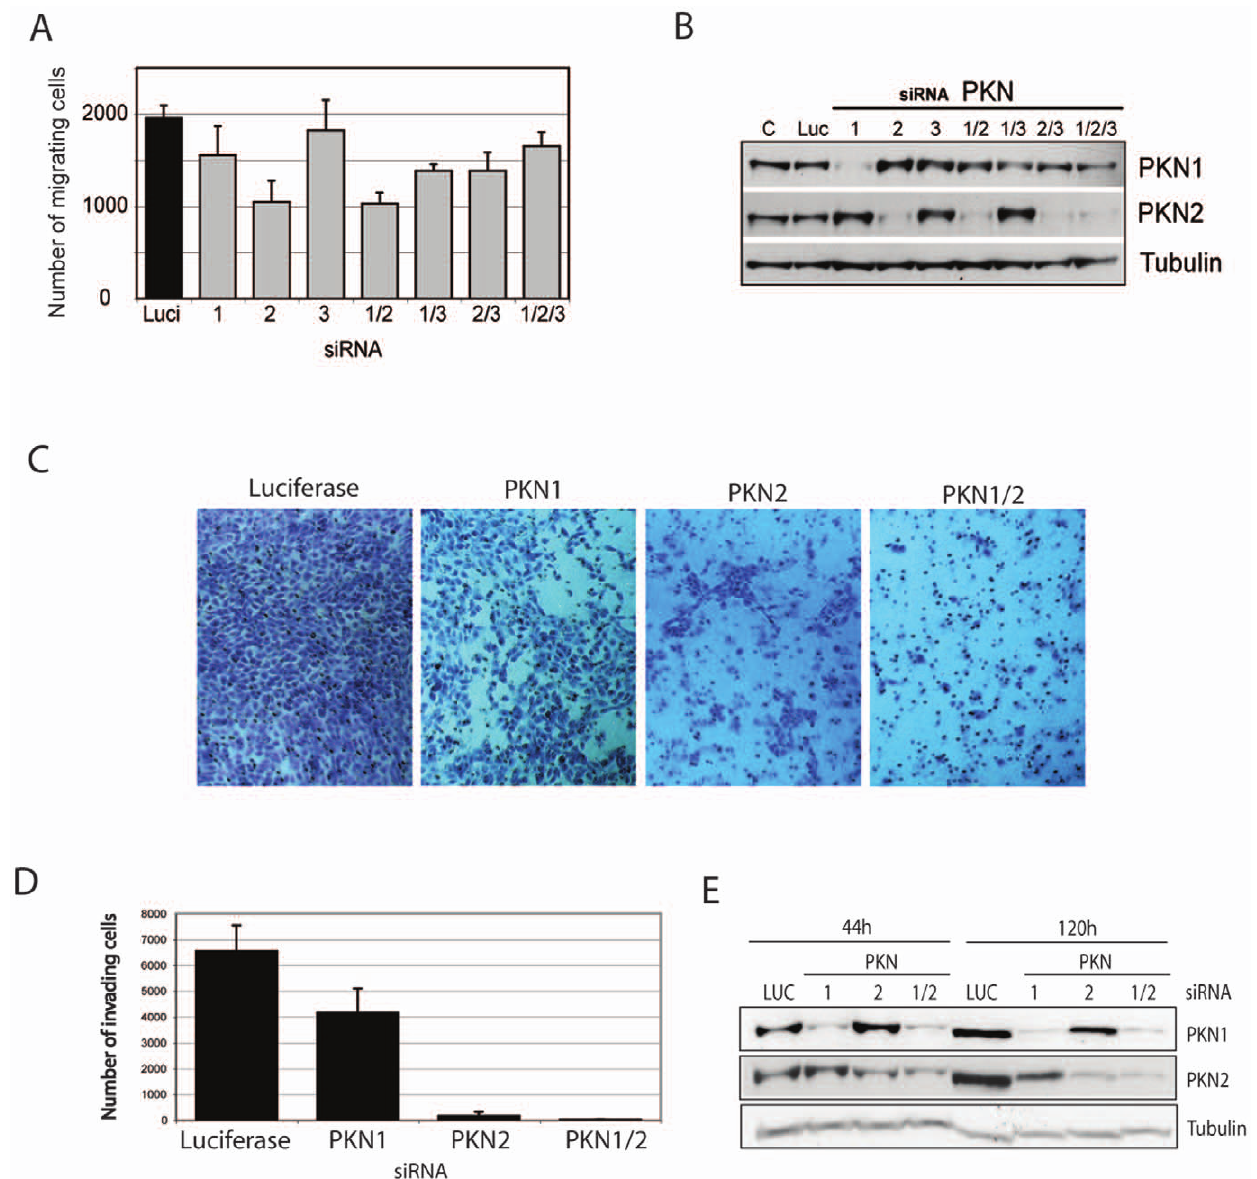
Figure 3. Effect of PKN knock down on tumour cell invasion. A. 5637 cells were transfected with siRNA against all PKN isforms either individually or as a double or triple knock down. 48 h post transfection cells were counted and seeded onto laminin coated Transwell membranes. Cells were allowed to migrate along a serum gradient for 12 h. Cells were then fixed at the bottom of the filter and counted. B. Western Blot of an equivalent aliquot of the seeded cells confirms the different efficiencies of PKN knock down. C. 5637 cells were transfected with siRNA against PKN1or 2 or both. 48 h post transfection cells were counted and then seeded into BD invasion chambers. Invasion was allowed to proceed for 66 h at 37 u C. Matrigel was then removed from the inside of the chamber and cells were fixed at the bottom of the chamber and photographed. D. Invading cells were counted for each condition (panel C) and compared to the number of invading luciferase control cells. E. Equivalent aliquots of PKN depleted cells as seeded into invasion chambers, were taken for western blots as well as for reseeding into 12 well plates and growth during the duration of the invasion assay. This allowed a reference point for PKN knock down after 120 h and confirms that the effect of PKN knock down on invasion is not due to proliferation